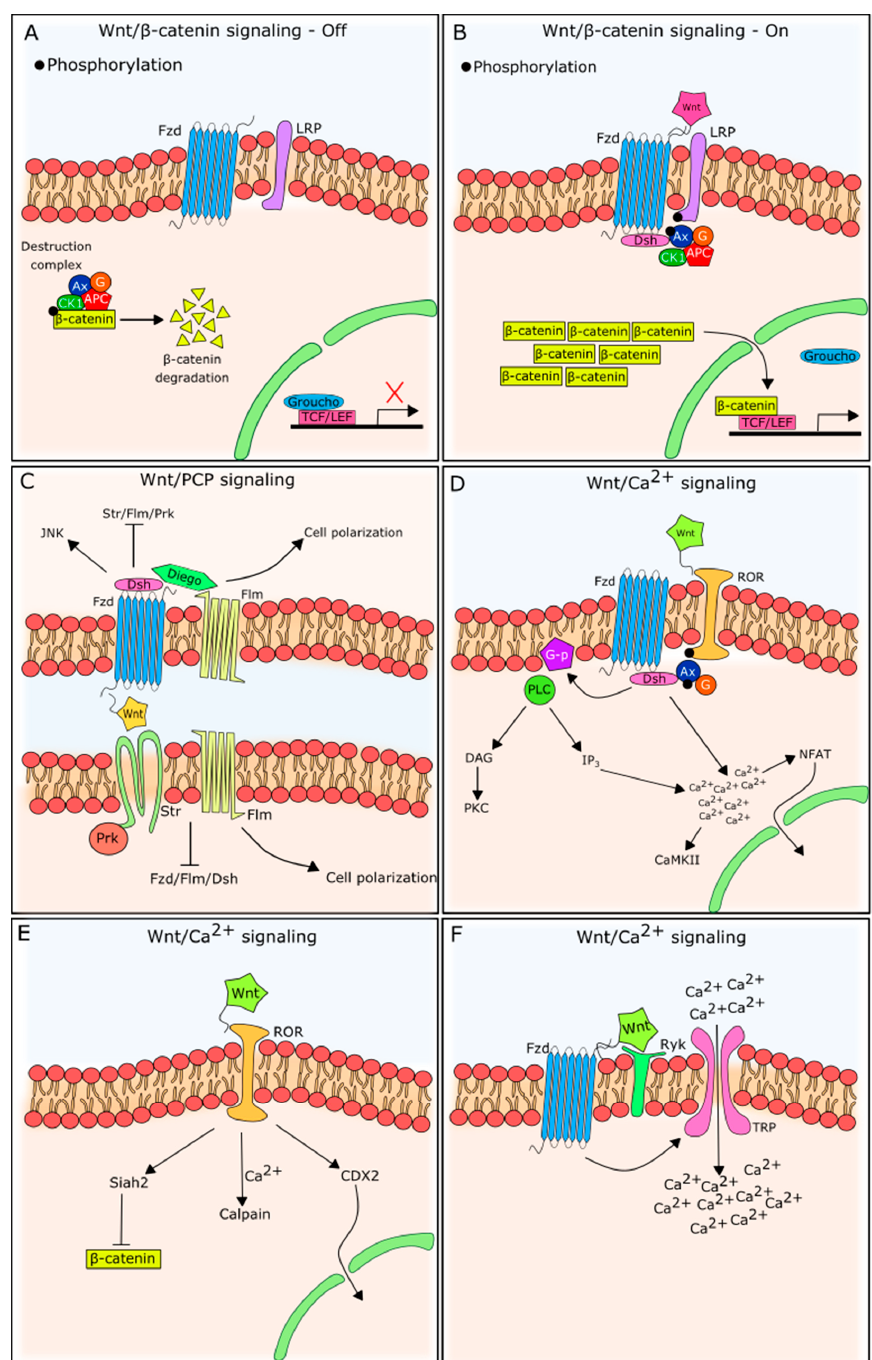
Figure 2. Wnt signaling scheme. ( A ) Wnt/ β -catenin dependent signaling in its inactive status. There is no Wnt ligand and receptor binding, so the destruction complex targets β -catenin, routing it for degradation. Expression of TCF / LEF genes is inhibited by Groucho. Fzd—Frizzled receptor; Ax—Axin; G—GSK-3 β ; CK1—casein kinase 1; APC—adenomatous polyposis coli. ( B ) Wnt/ β -catenin dependent signaling in its active status. After Wnt ligand and Fzd receptor binding, in the presence of LRP, the destruction complex is attracted to the plasma membrane region by Dsh action. β -catenin is not degraded and accumulates in the cytoplasm and nucleus, activating transcription of TCF / LEF genes. Dsh—Dishevelled. ( C ) Wnt / PCP signaling is independent of β -catenin and relies on asymmetric distribution of membrane proteins. At one cellular side, there is Dsh recruitment as well, however